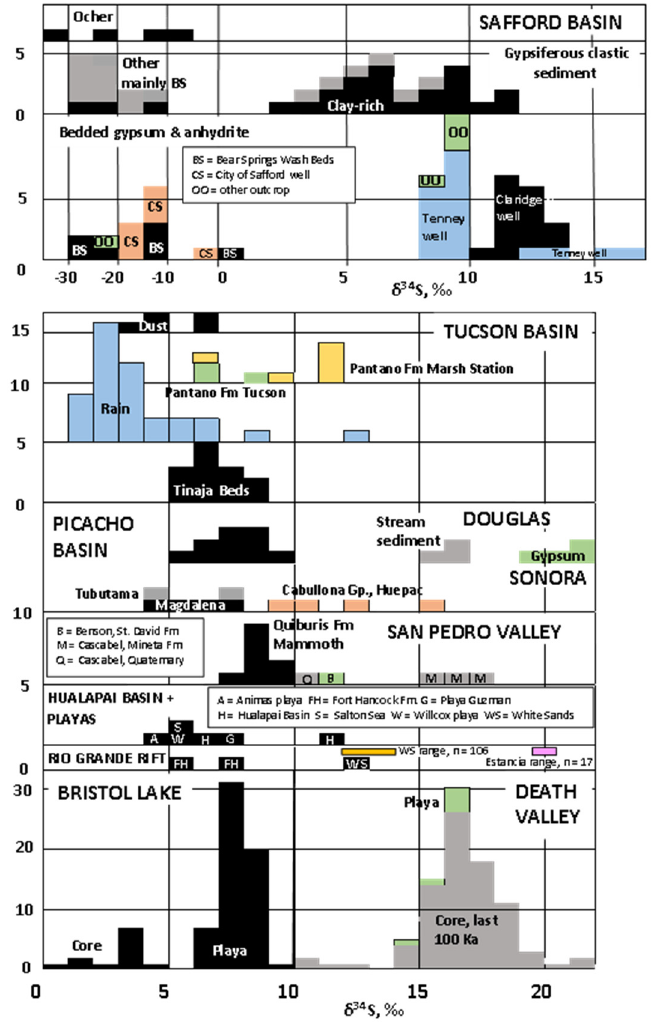
Figure 4. Histogram of δ 34 S data for evaporites and playas, and data for rain and dust in Tucson Basin. Data are from this study, except: ranges for White Sands and Estancia Basin [60], Hualapai Basin [16], Bristol Dry Lake [57], Death Valley [59].